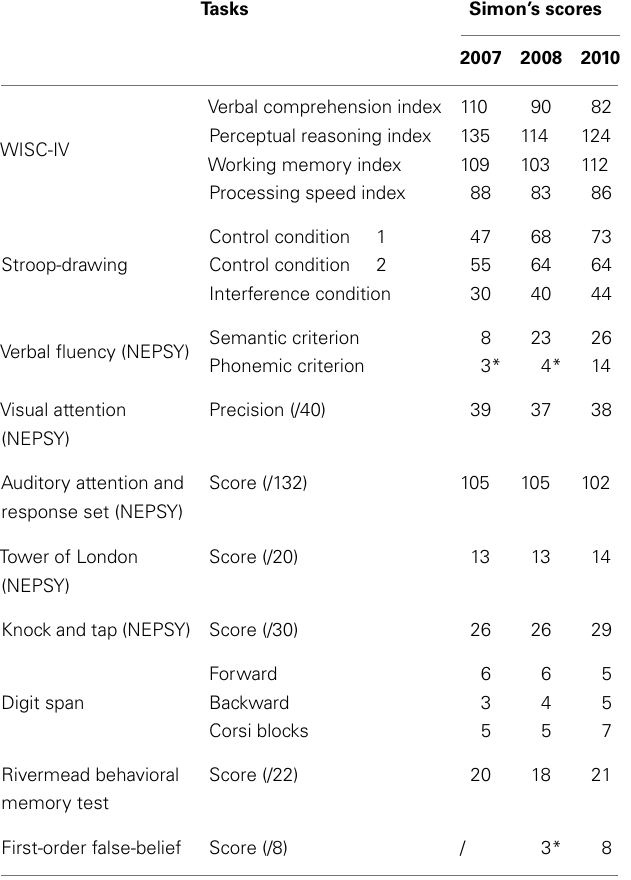
Table 1 | General cognitive assessment.